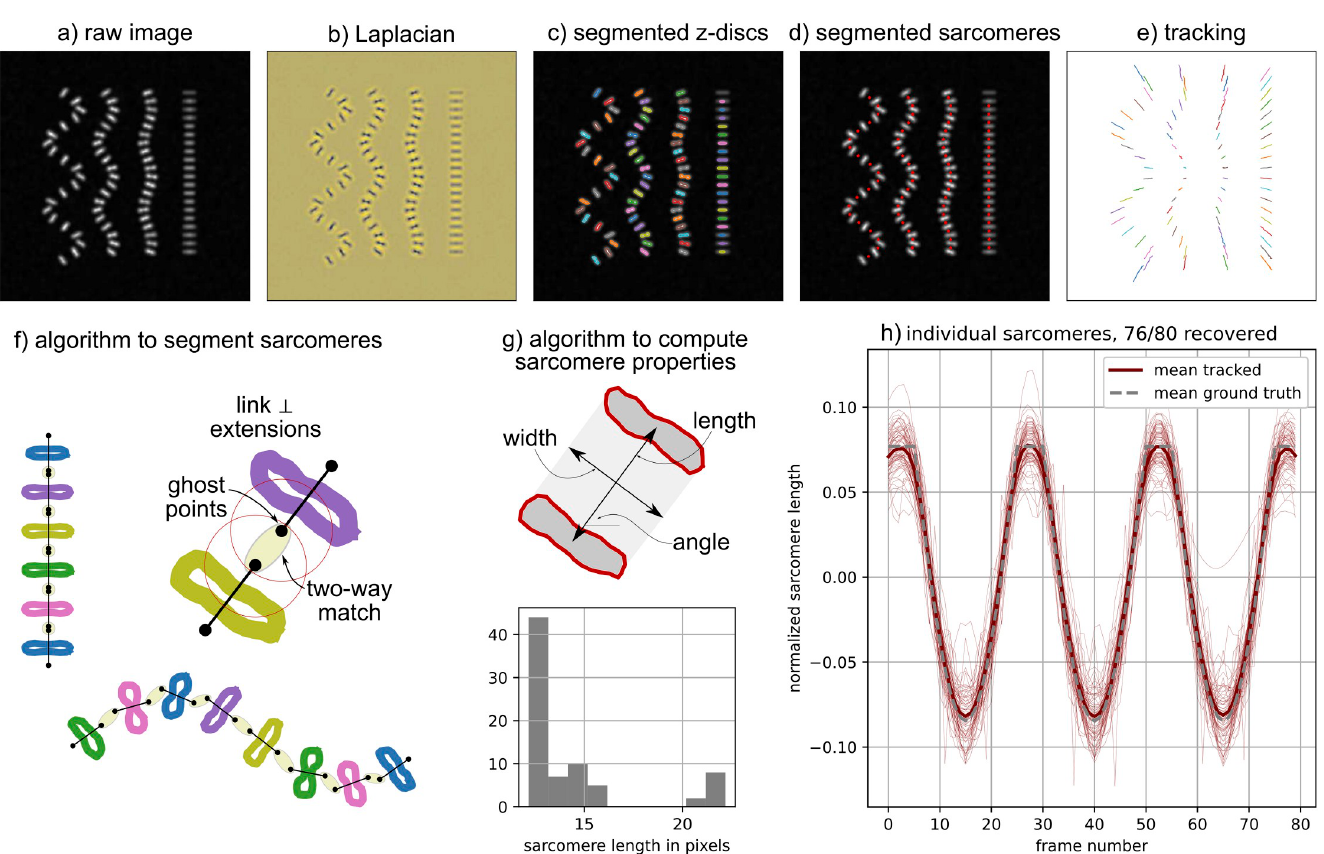
Fig 3. Segmenting and tracking the z-discs and sarcomeres: (a) An example of a raw synthetic two-dimensional (2D) input image; (b) The Laplacian of the input image is used to detect the high gradients present at the edge of every z-disc [27]; (c) z-discs are identified as closed contours where the value of the Laplacian exceeds the threshold computed with Otsu’s method [28]; (d) Sarcomeres are procedurally identified from the segmented z-discs; (e) Sarcomeres and z-discs are tracked independently between frames with the Python trackpy package [29]; (f) The algorithm to segment sarcomeres is based on linking the approximately parallel z-discs to their closest neighbors in the direction perpendicular to the z-disc; (g) Sarcomere properties are computed from the pair of associated z-discs; (h) Tracking each sarcomere leads to multiple spatially resolved time series.